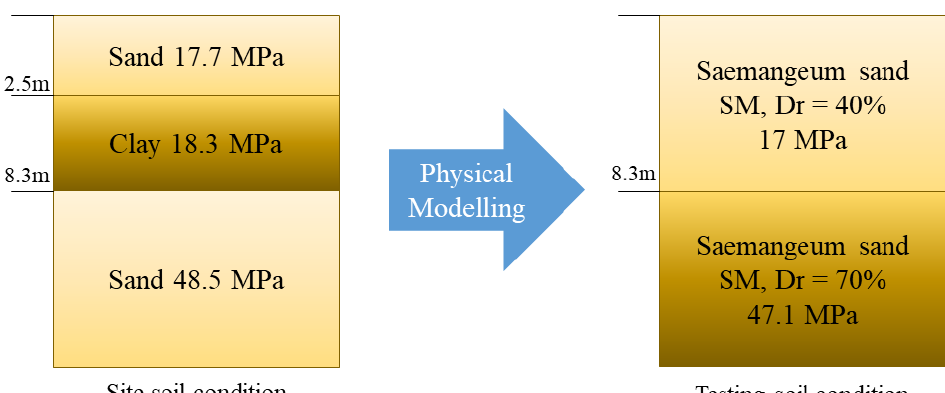
Figure 2. Elastic modulus (E) of site and soil model.